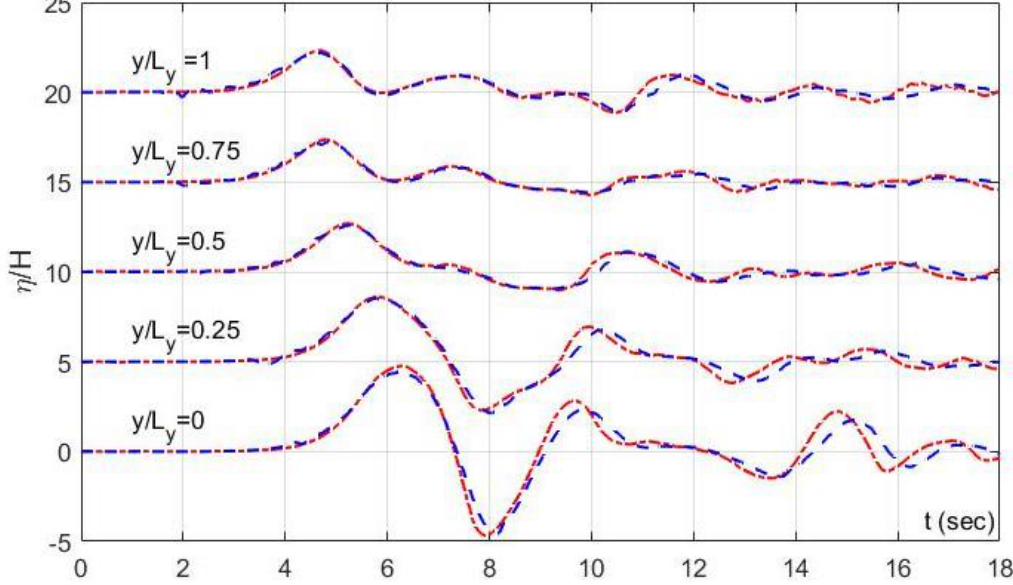
Figure 7. Wave signal at several cross-sections y / L y = 0,0.25,0.5,0.75,1, the numerical MCS-2d scheme (blue) versus another SWE solver by Özkan-Haller and Kirby, 1997 [23]